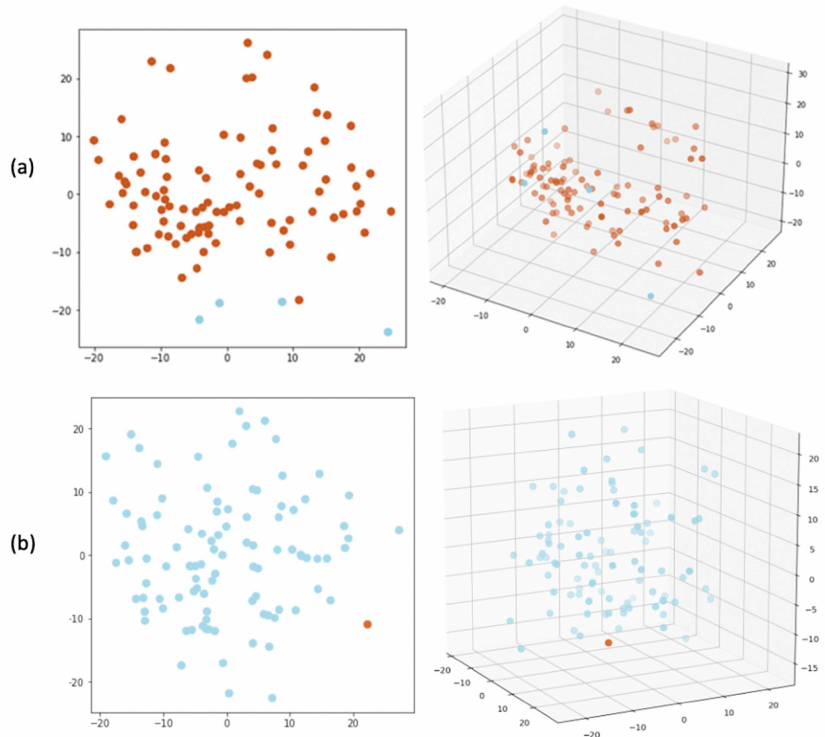
Figure 16. Unsupervised clustering visualization using agglomerative clustering algorithm, ( a ) session number 3 and ( b ) session number 5 of all